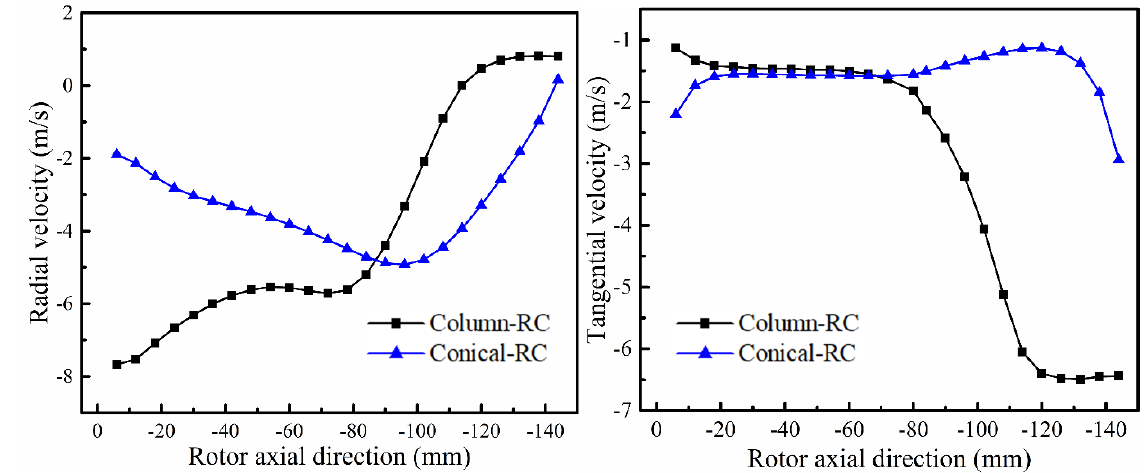
Figure 6. The radial and tangential velocity distributions of airflow at the rotor cage entrance.